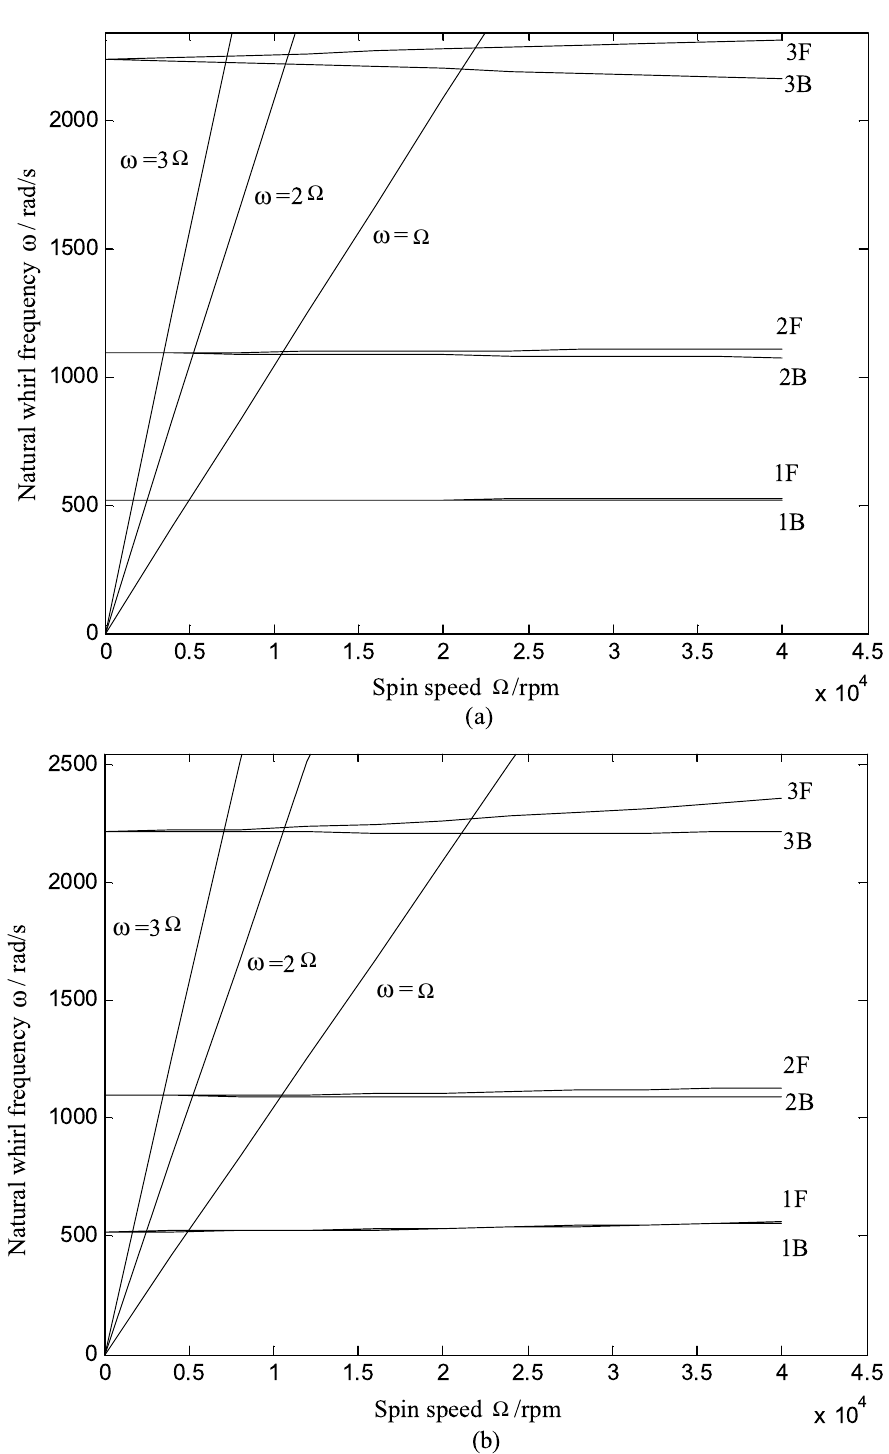
Fig. 3. Whirl speed maps of a rotor-bearing system supported on undamped isotropic bearing. (a) The shaft material with hysteretic damping η H = 0.0002, and (b) viscous damping η V = 0.0002